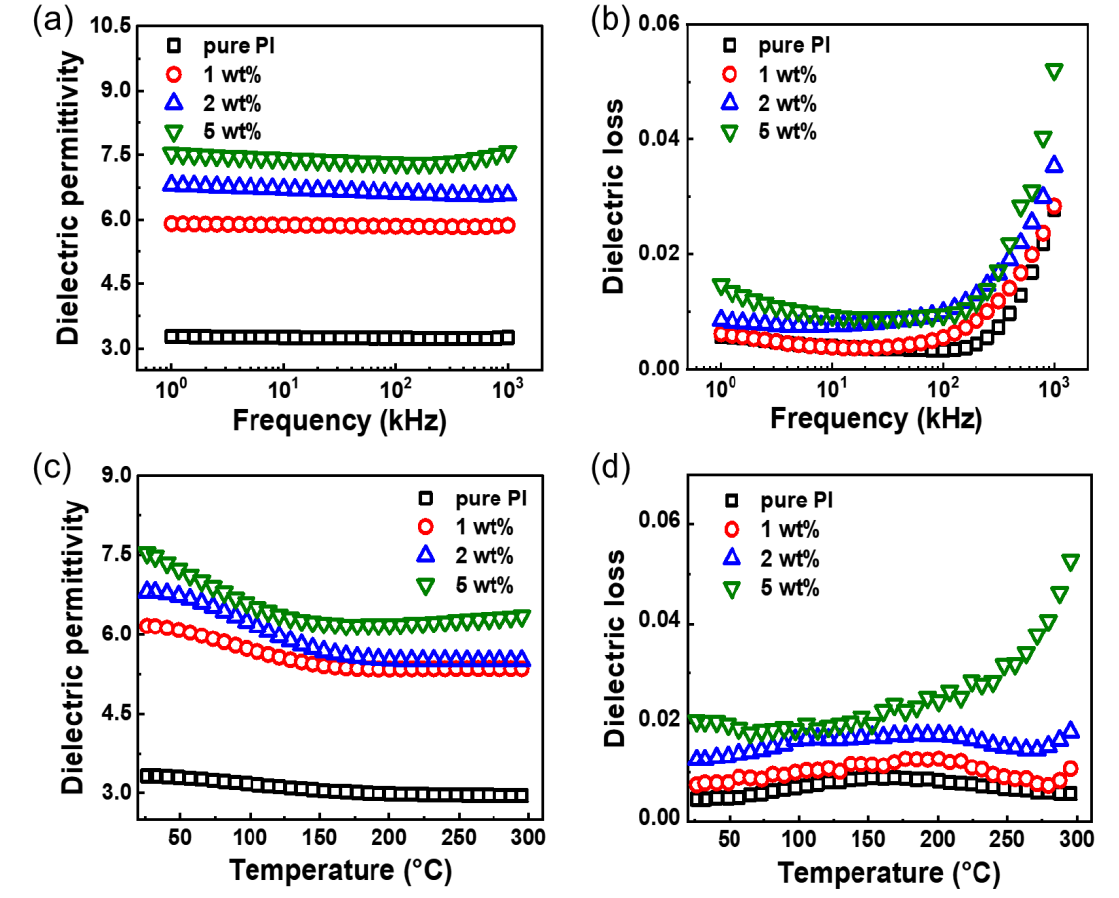
Figure 3. Dielectric properties of TiO 2 /PI nanocomposite. Frequency-dependent ( a ) dielectric permittivity and ( b ) dielectric loss of pure PI and TiO 2 /PI nanocomposites with various loading contents of 1, 2, and 5 wt% at RT. Temperature-dependent ( c ) dielectric permittivity and ( d ) dielectric loss of pure PI and TiO 2 /PI nanocomposites with various loading contents of 1, 2, and 5 wt% at 1 kHz.